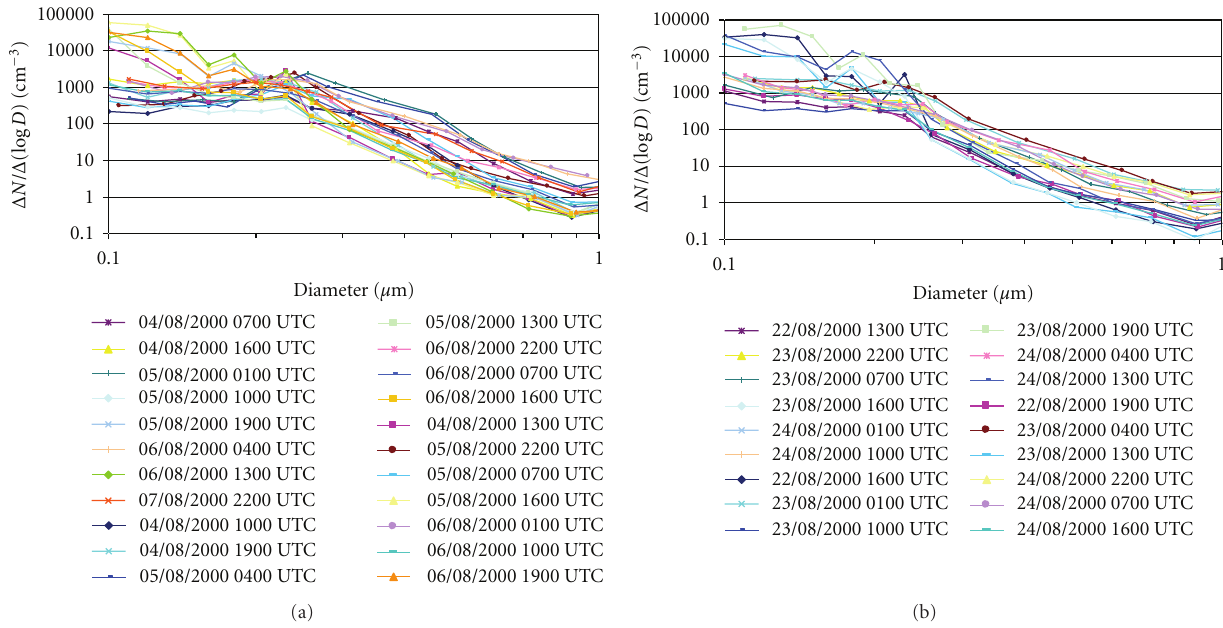
Figure 7: Aerosol size distributions of two time intervals: (a) between 4th August 2000 at 0700 UTC and 7th August 2000 at 2200 UTC and (b) between 22nd August 2000 at 1300 UTC and 24th August 2000 at 1600 UTC, representing measurements contaminated by wildfires. Only the sizes between 0.1 and 1 μ m are shown.